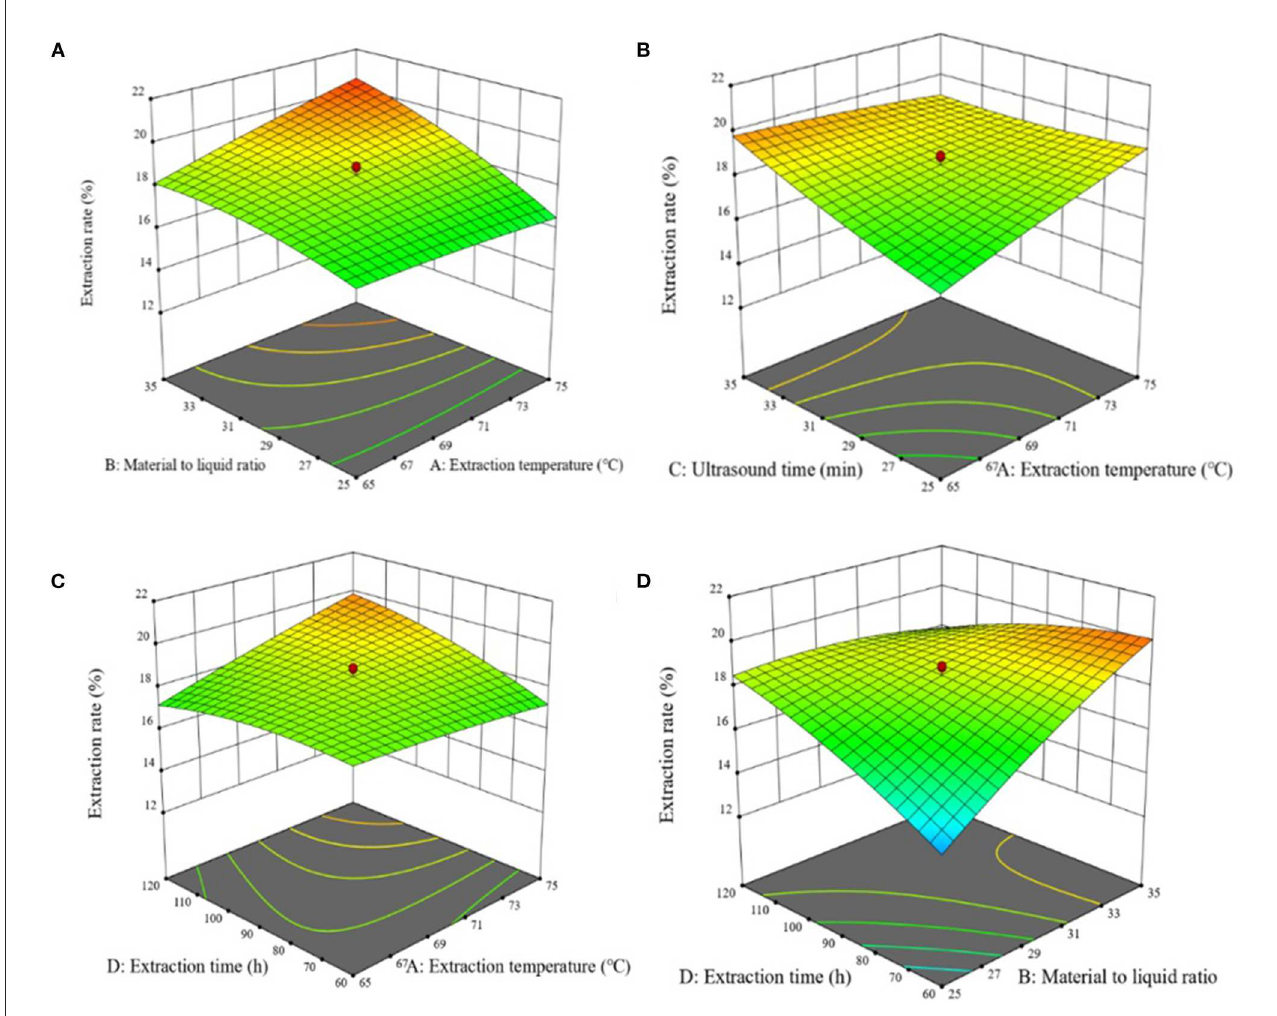
FIGURE2 Effects of response on extraction yield of chestnut polysaccharides (A) ultrasonic time and sodium selenite concentration (B) polysaccharide concentration and selenization temperature (C) sodium selenite concentration and selenization temperature (D) sodium selenite concentration and selenization